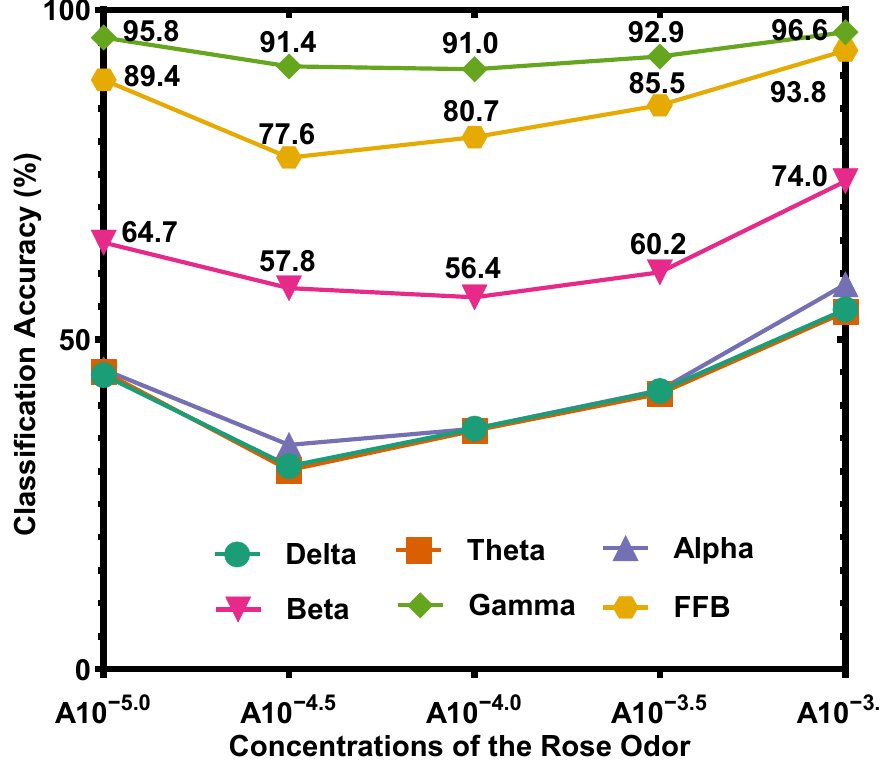
Figure 4. Average classification accuracy across 13 participants for five different rose odor concentrations (using SVM classifier).